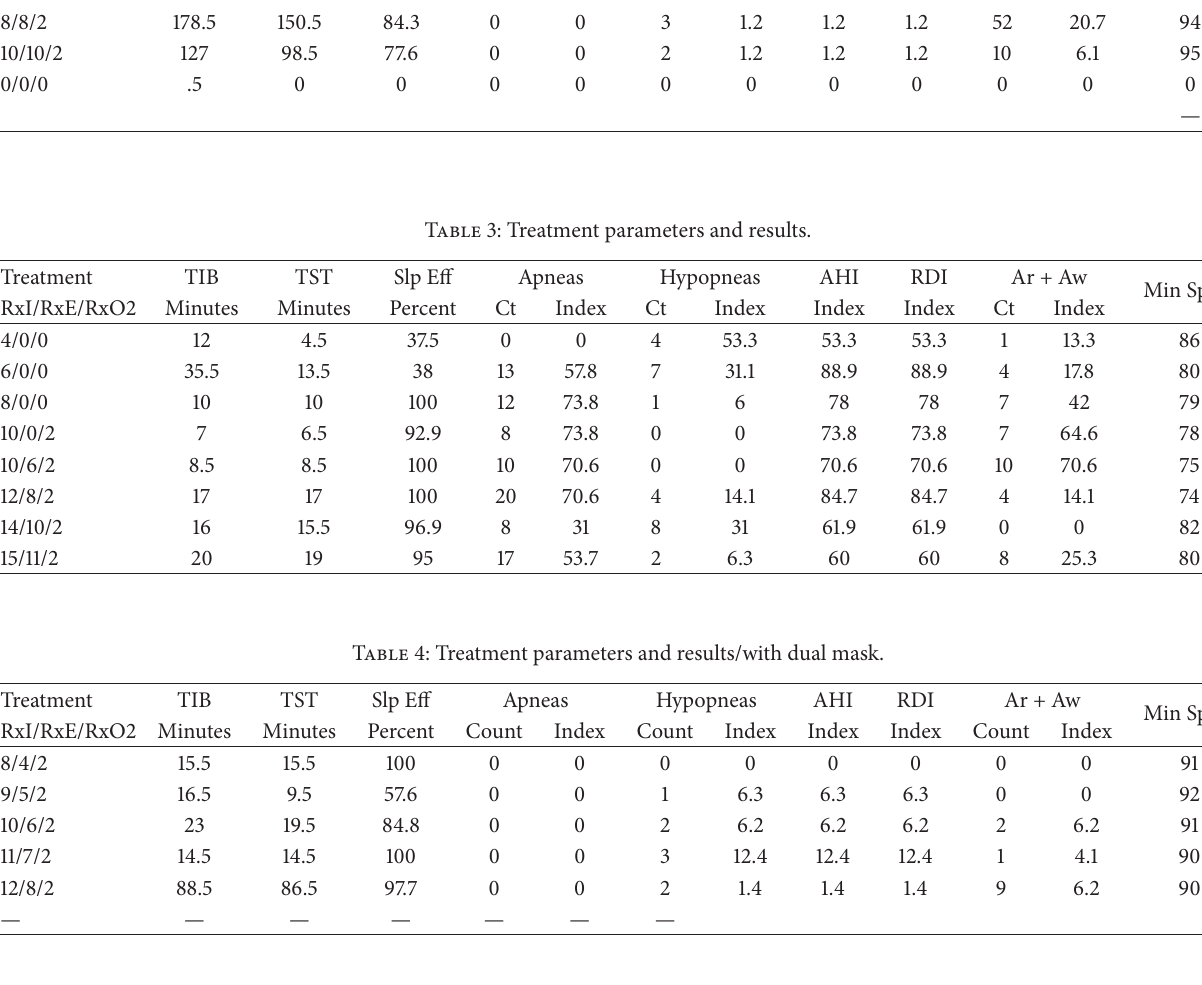
Table 2: Treatment parameters and results/with dual mask.